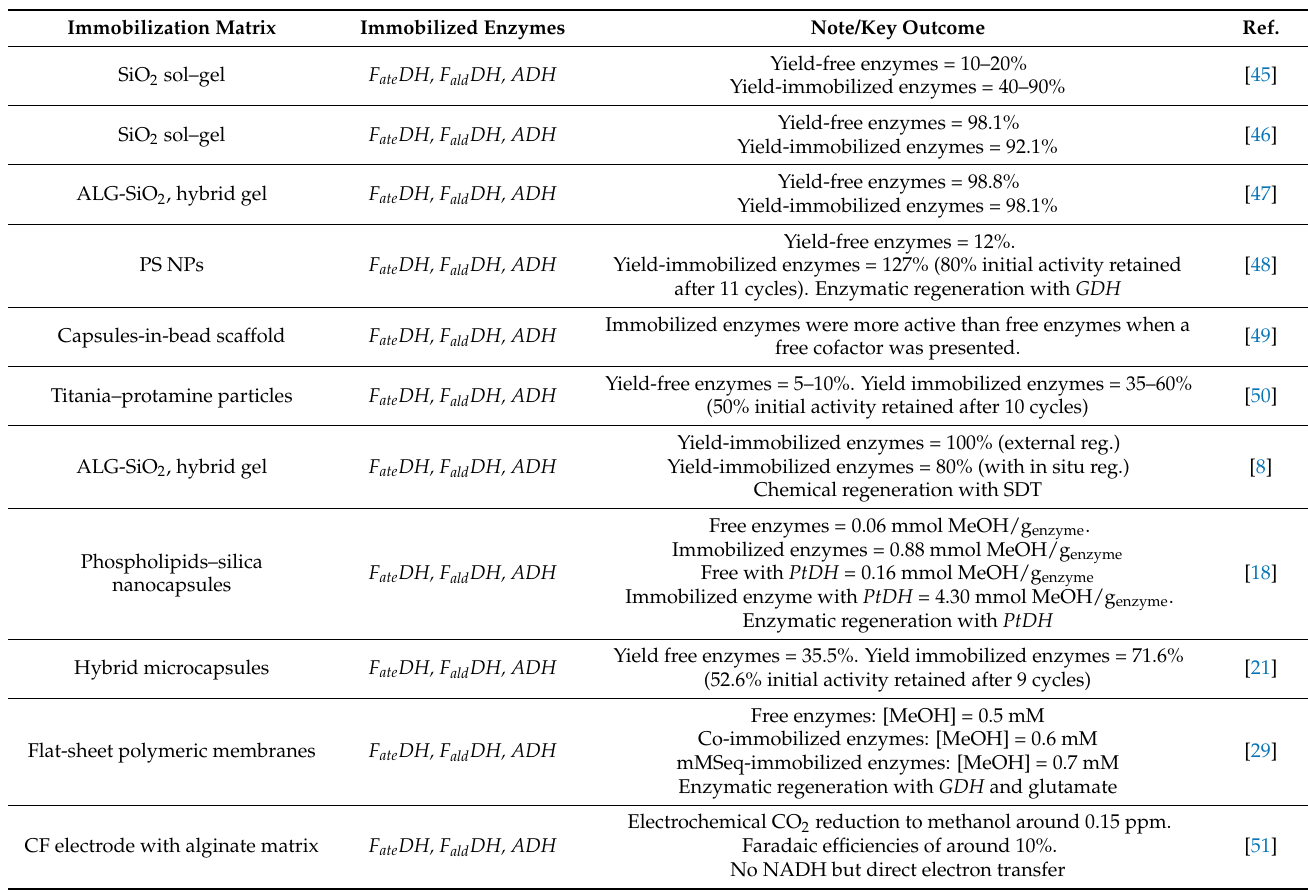
Table 4. Enzymes immobilization methods and bibliographic key